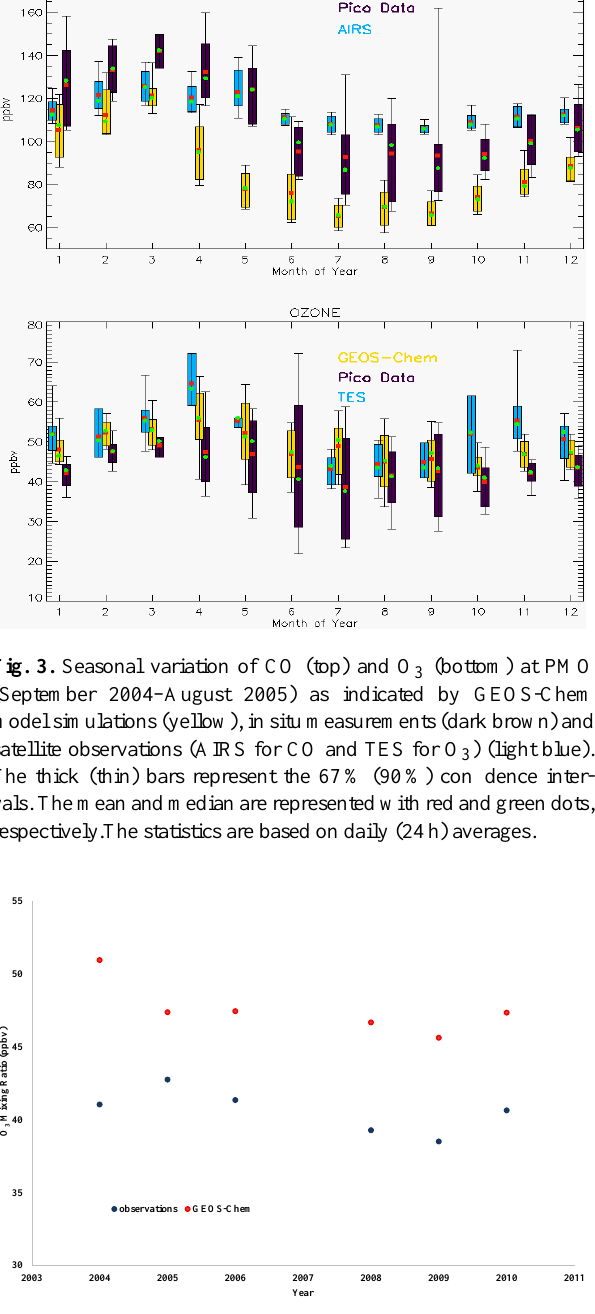
Fig. 4. Seasonal (May–August) average O 3 for 2004–2010 from observations (blue) and GEOS-Chem simulation (red).